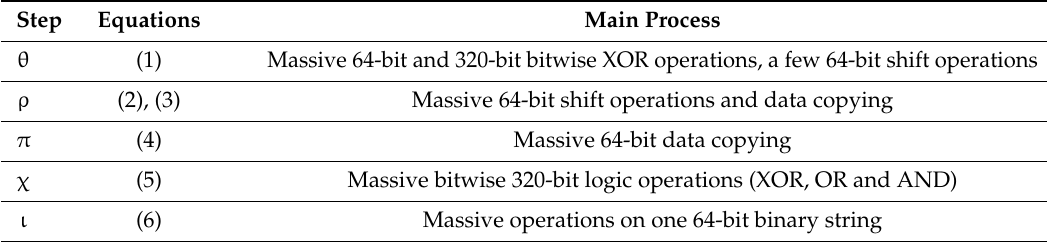
Table 1. Five steps in Keccak- f permutation.